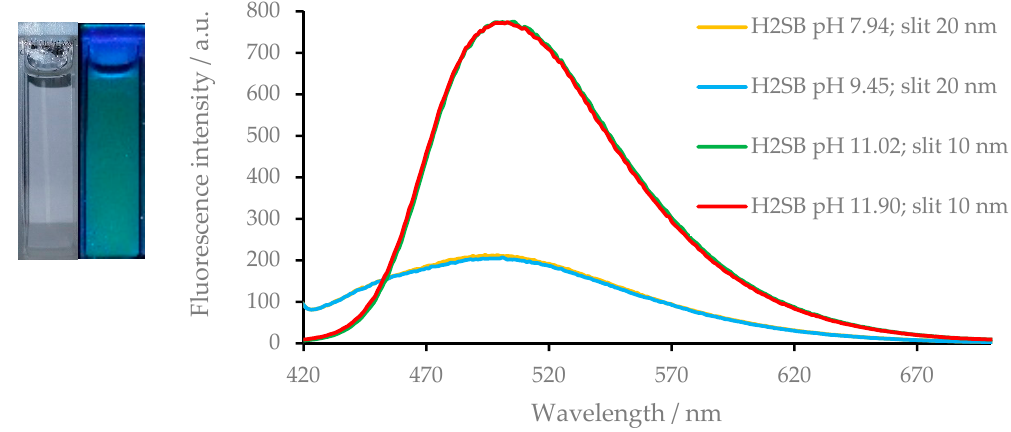
Figure 6. Left: Fluorescent photographic image under UV lamp (365 nm) obtained for the blue-emitting H 2 SB (an image under daylight has been included to facilitate comparison). Right: Fluorescence spectrum of H 2 SB (100 μ M,) measured in methanol-water in 80:20 v/v at different pH values.